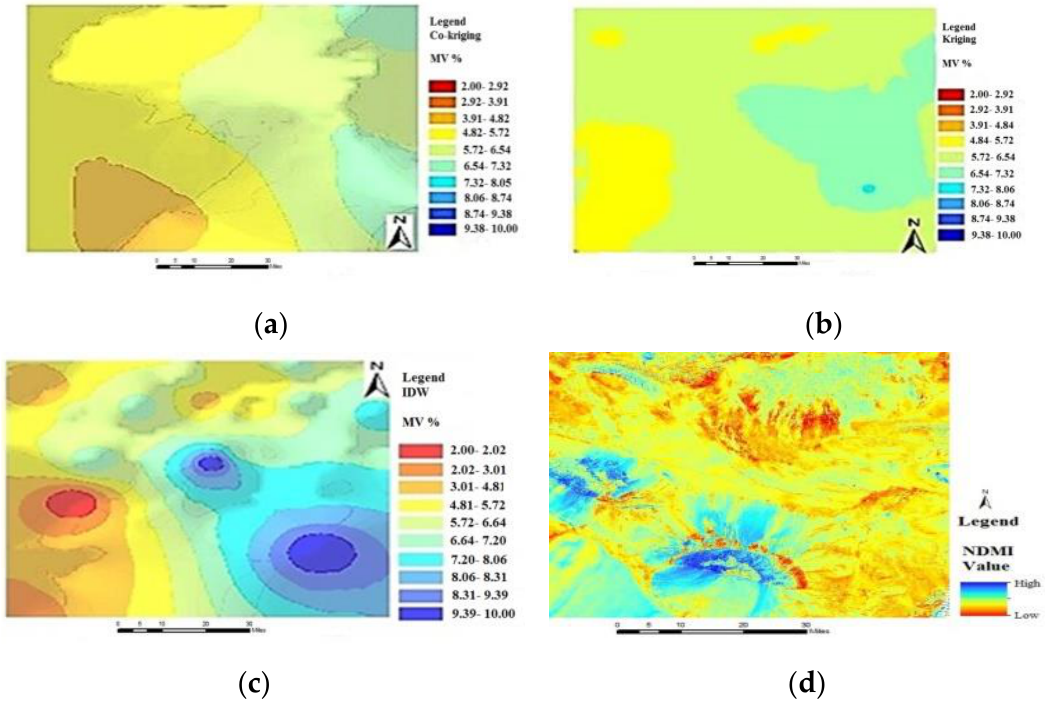
Figure 12. The SM map created by ( a ) co-kriging; ( b ) kriging; ( c ) IDW method, and ( d ) NDMI index using Landsat TM data.